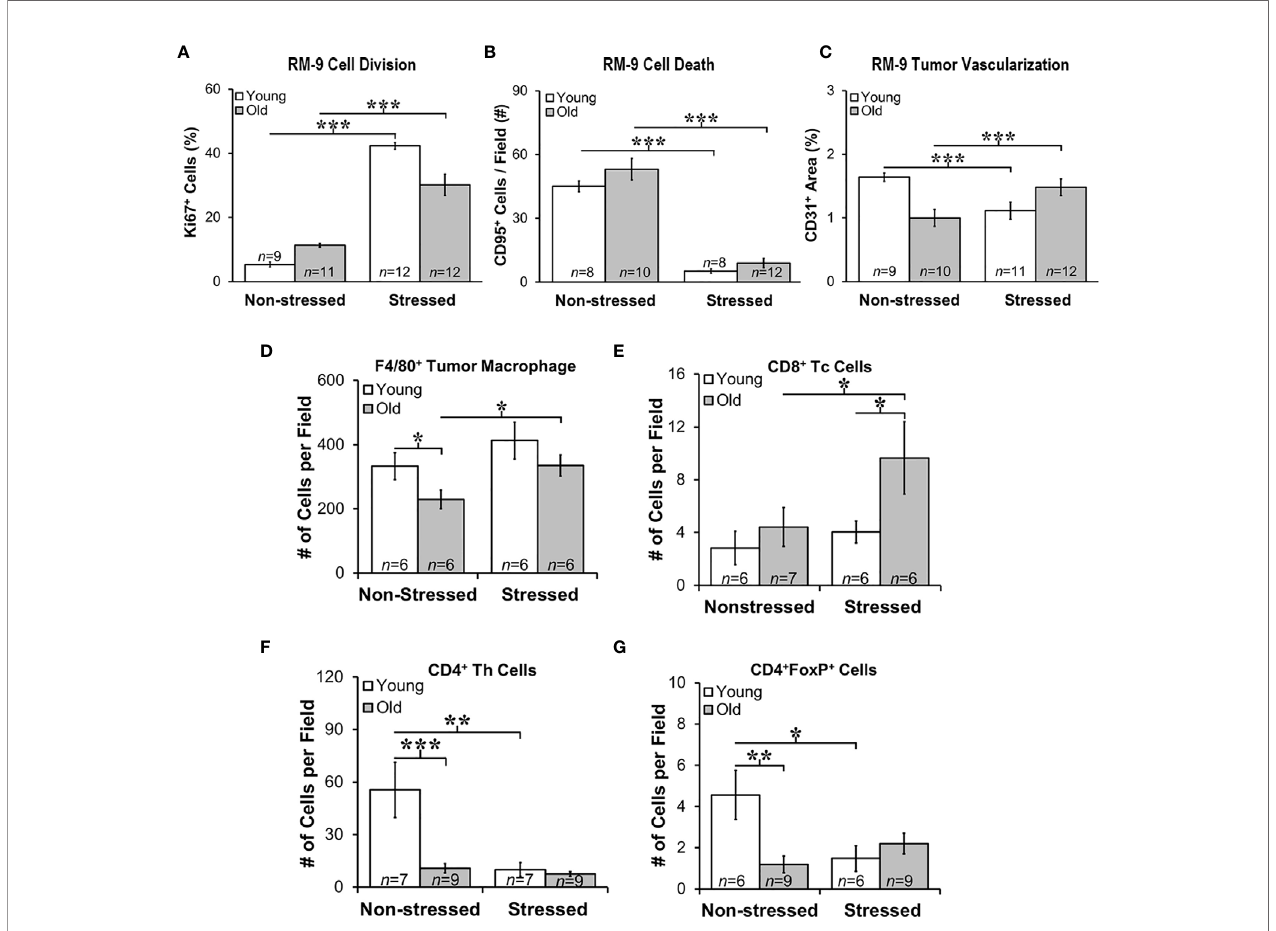
FIGURE 5 | Stress Promoted Tumor Proliferation and Apoptosis, but Age-dependent In fi ltration of Immune Cell Subsets and Vascularization Support Age-dependent Anti-tumor Defense Mechanisms. Quantitation of immunostaining for proliferation (A) , apoptosis (B) , angiogenesis (C) , F4/80 + macrophages, and CD8 + , CD4 + , and CD4 + FoxP + cells (D – G , respectively) in young (open bar) and old (gray bar) non-stressed and stressed mice D14 after orthotopic prostate tumor inoculation. (A) Stress increased prostate tumor expression of Ki67 in young and old mice compared with non-stress age-matched mice. (B) Conversely, CD95 expression was lower in RM-9 tumors from stressed than in non-stressed young and old mice. (C) CD31 immunoreactivity was higher in stressed than non-stressed old mice, but in young mice expression was greater in non-stressed than the stressed group. (D) F4/80 + tumor macrophages were fewer (* p < 0.05) in old than young non-stressed mice, but were higher in stressed than non-stressed old mice. (E) CD8 + Tc cell numbers were similar in non-stressed mice, but were higher in old than young in stressed mice. Moreover, more ( p <0.05) CD8 + cells were present in old than young stressed mice. (F) CD4 + , including those expressing FoxP3 + (G) , were lower in old than young non- stress mice, and in young stressed than non-stressed mice. * p < 0.05, ** p < 0.01, *** p <